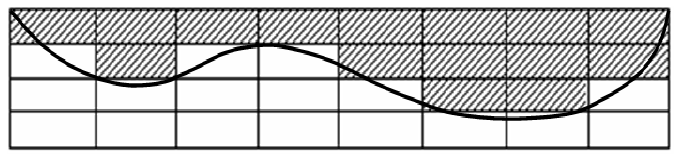
Figure 8. Inversion results q = [1 2 1 1 2 3 3 2]